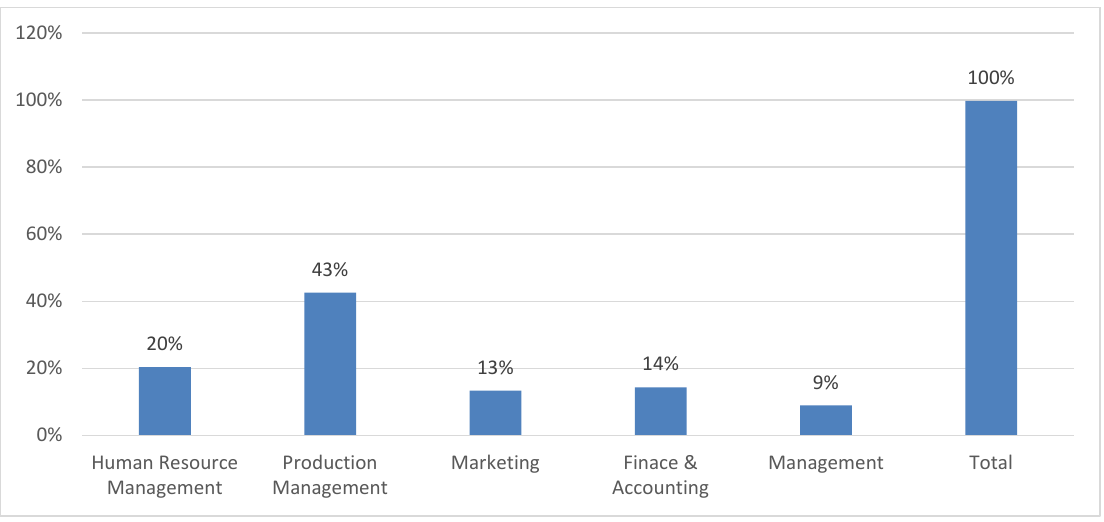
Fig. 1. Issues faced by SMEs in